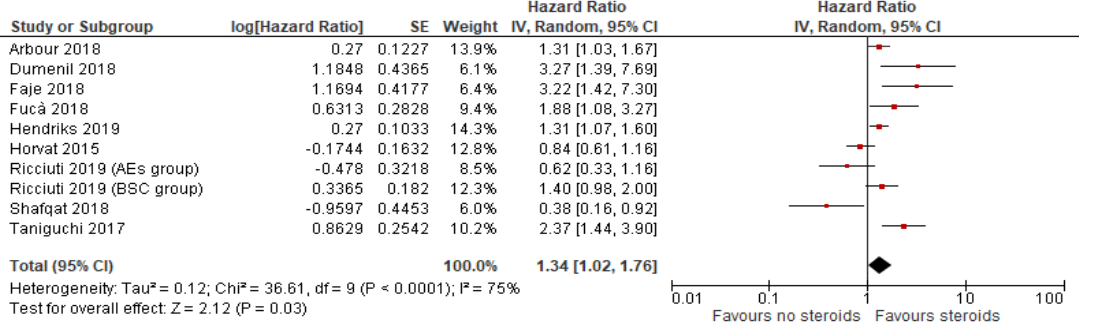
Figure 3. Progression-free survival comparing use or not of steroids concomitant to immune checkpoint in patients with cancer.